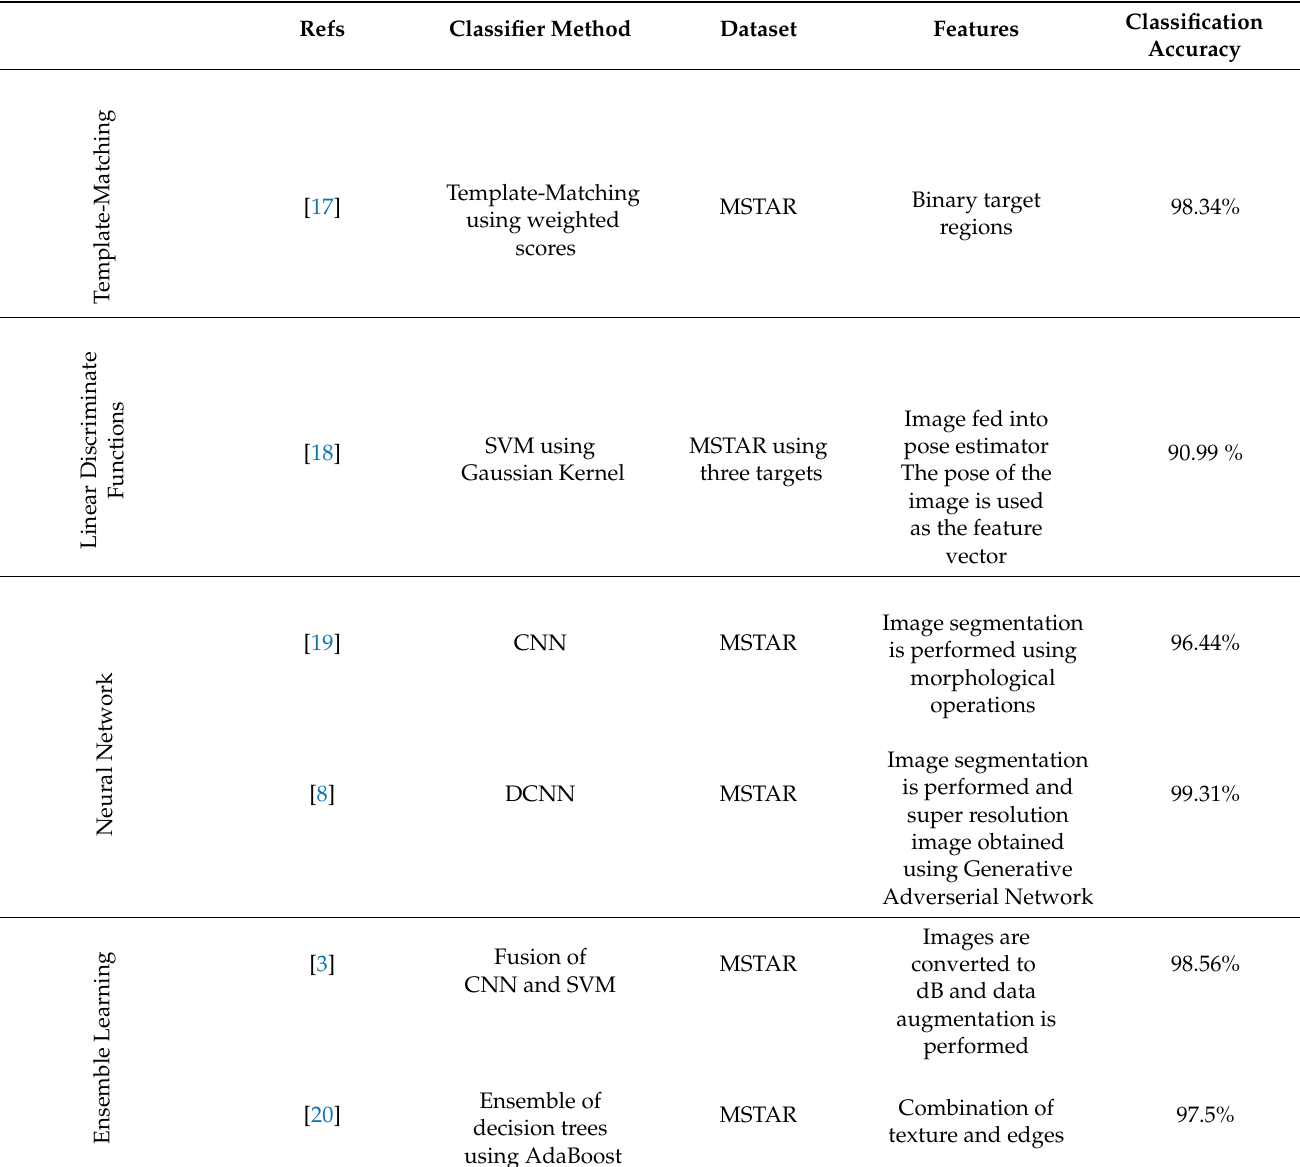
Table 1. Comparison of Various Feature-Based ATR of SAR